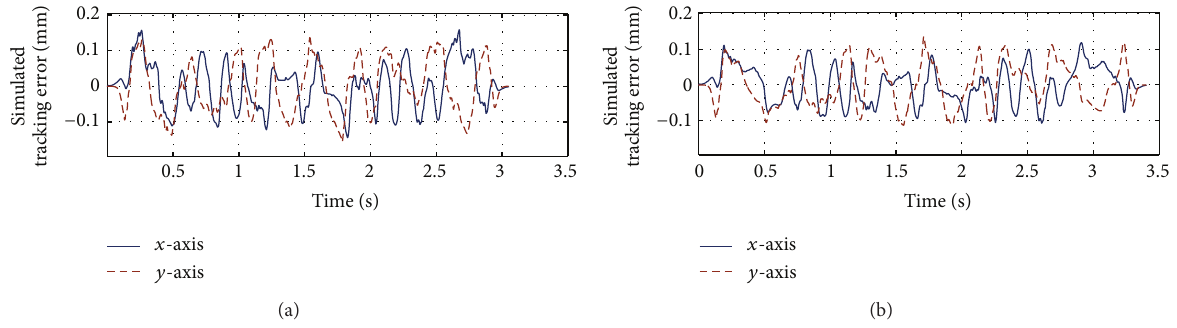
Figure 14: Simulated tracking error curves under the (a) SMTT and (b) TEC-SMTT commands.